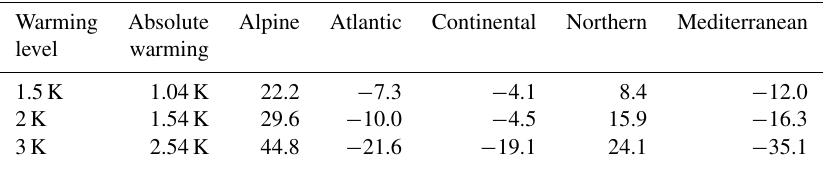
Table 2. Relative changes (%) in streamflow Q90 between the past (1971–2000) and different warming levels averaged over IPCC AR4 Europe regions shown in Fig. 2.